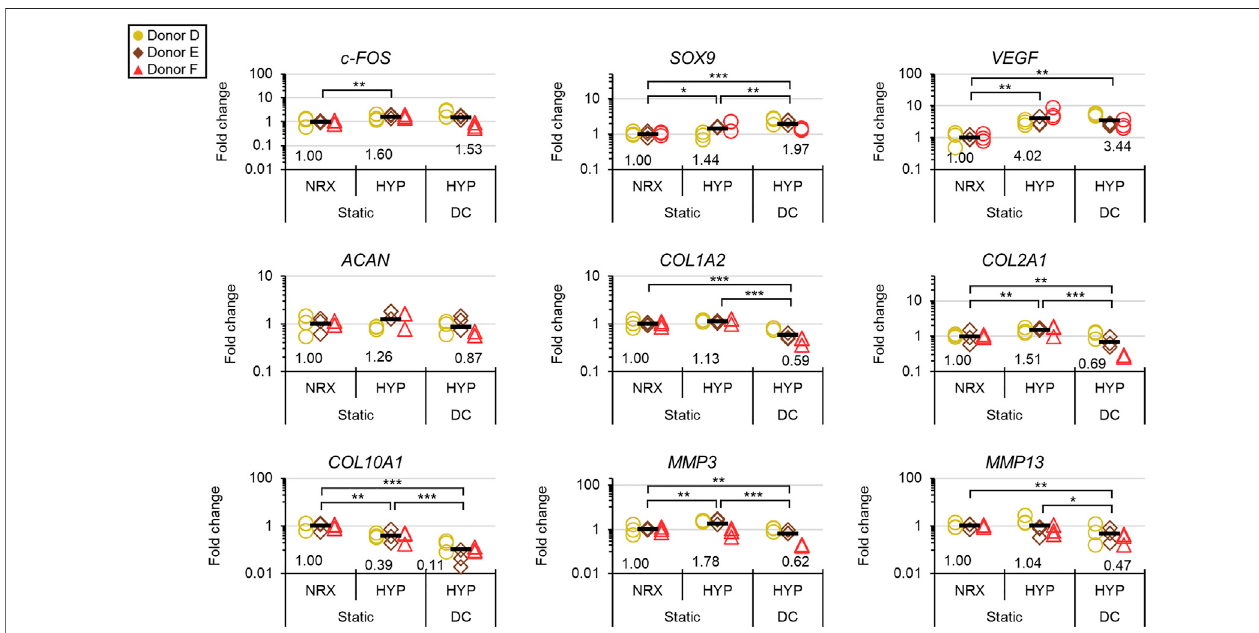
FIGURE 8 | Experiment III: Gene expression by qRT-PCR after the 3-weeks mechano-hypoxia treatment. Expression was measured 6 h after the fi nal loading event. Fold changes are with respect to the NRX/static group within each donor, and values for each gene of interest are normalized to the mean expression of housekeeping genes β -actin , B2M , and YWHAZ . *: p < 0.05, **: p < 0.01, ***: p < 0.001.